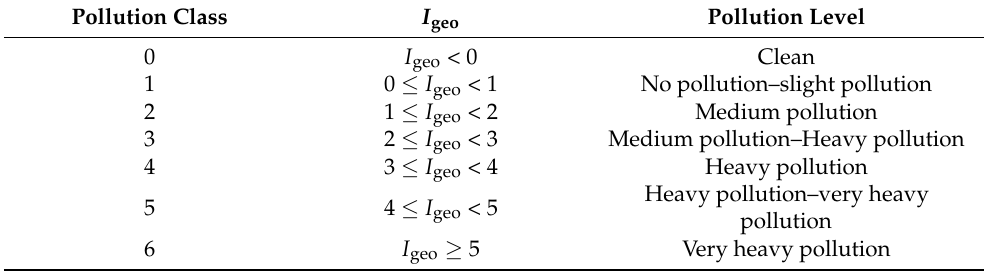
Table 3. Grading standard was evaluated by the ground accumulation index